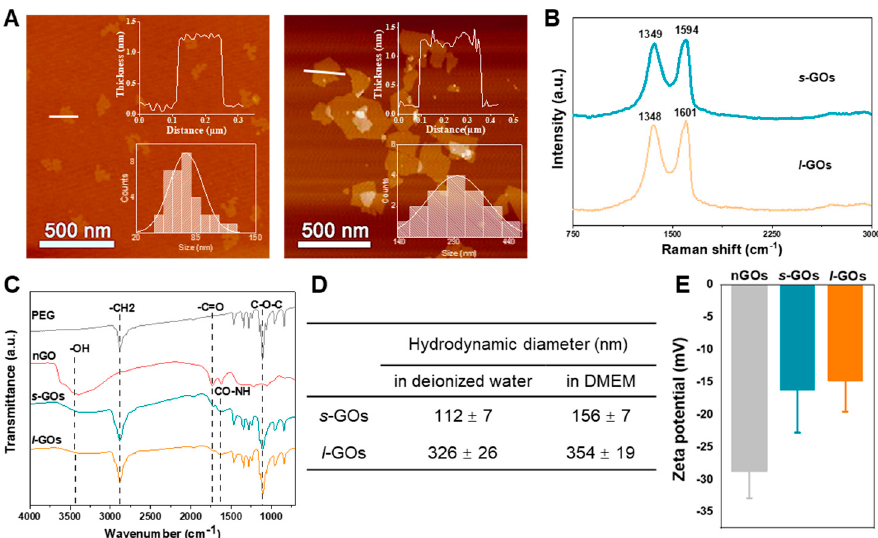
Figure 1. Physicochemical characterization of s ‐ GOs and l ‐ GOs. ( A ) AFM images of s ‐ GOs and l ‐ GOs. The insert figures show the distribution of thickness and lateral dimensions of GOs. ( B ) Raman spectra of s ‐ GOs and l ‐ GOs. ( C ) FTIR spectra of PEG, nGOs, s ‐ GOs, and l ‐ GOs. ( D ) Hydrodynamic diameter of s ‐ GOs and l ‐ GOs measured by DLS in water and in DMEM. ( E ) Zeta potentials of s ‐ GOs and l ‐ GOs in deionized water measured by DLS. nGOs: non − PEGylated